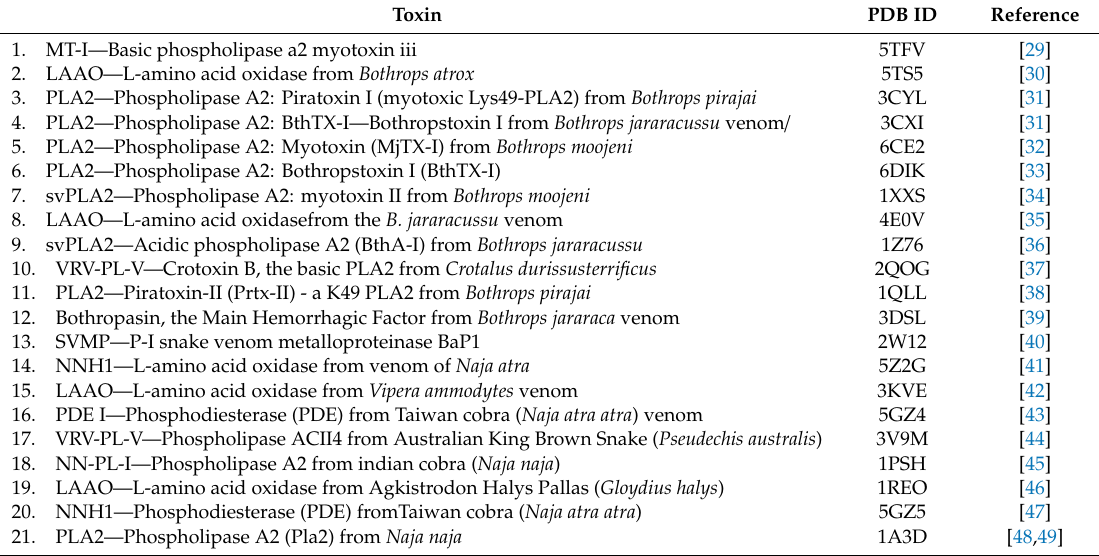
Table 2. Toxins from Ecuadorian (1–2), Latin American (3–13) or non-American (14–21) snakes, and the corresponding Protein Data Base Identifier (PDB ID).